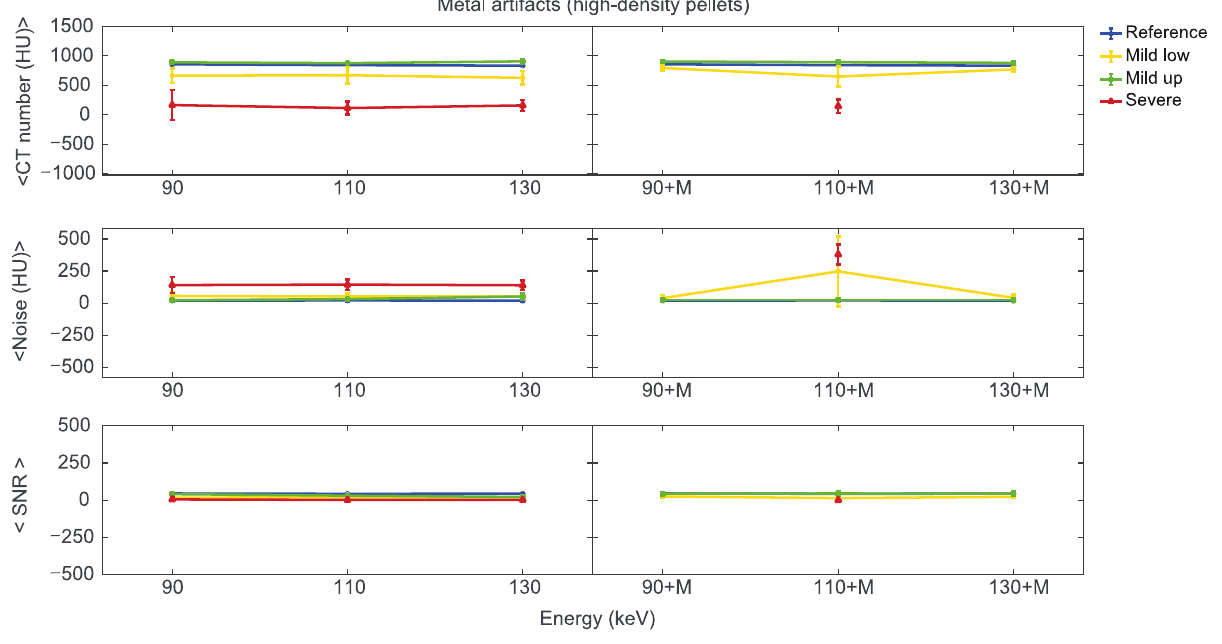
Figure 9. Mean CT number, noise, and SNR for high-density pellets of classified artifacts as a function of the reconstructed images, i.e., VMI without (90, 110, and 130) and with the MARS algorithm (90+M, 110+M, and 130+M). The values for mild low, mild up, and severe artifact are reported with yellow, green, and red lines, respectively. The reference values are indicated with a blue line.